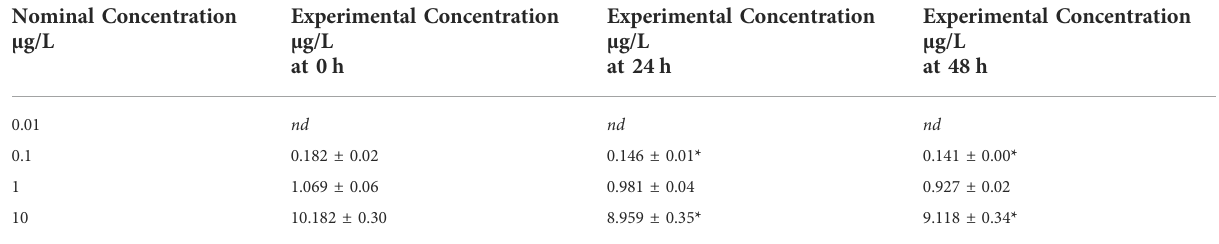
TABLE 3 Experimental concentrations of sertraline at 0, 24, and 48 h. Values represent the mean ± SE of three replicates. Results across time (24 and 48 h) were compared to those obtained at time 0 by Student ’ s t-test, signi fi cance was set to p < 0.05 and is represented as * when p < 0.05. nd — not